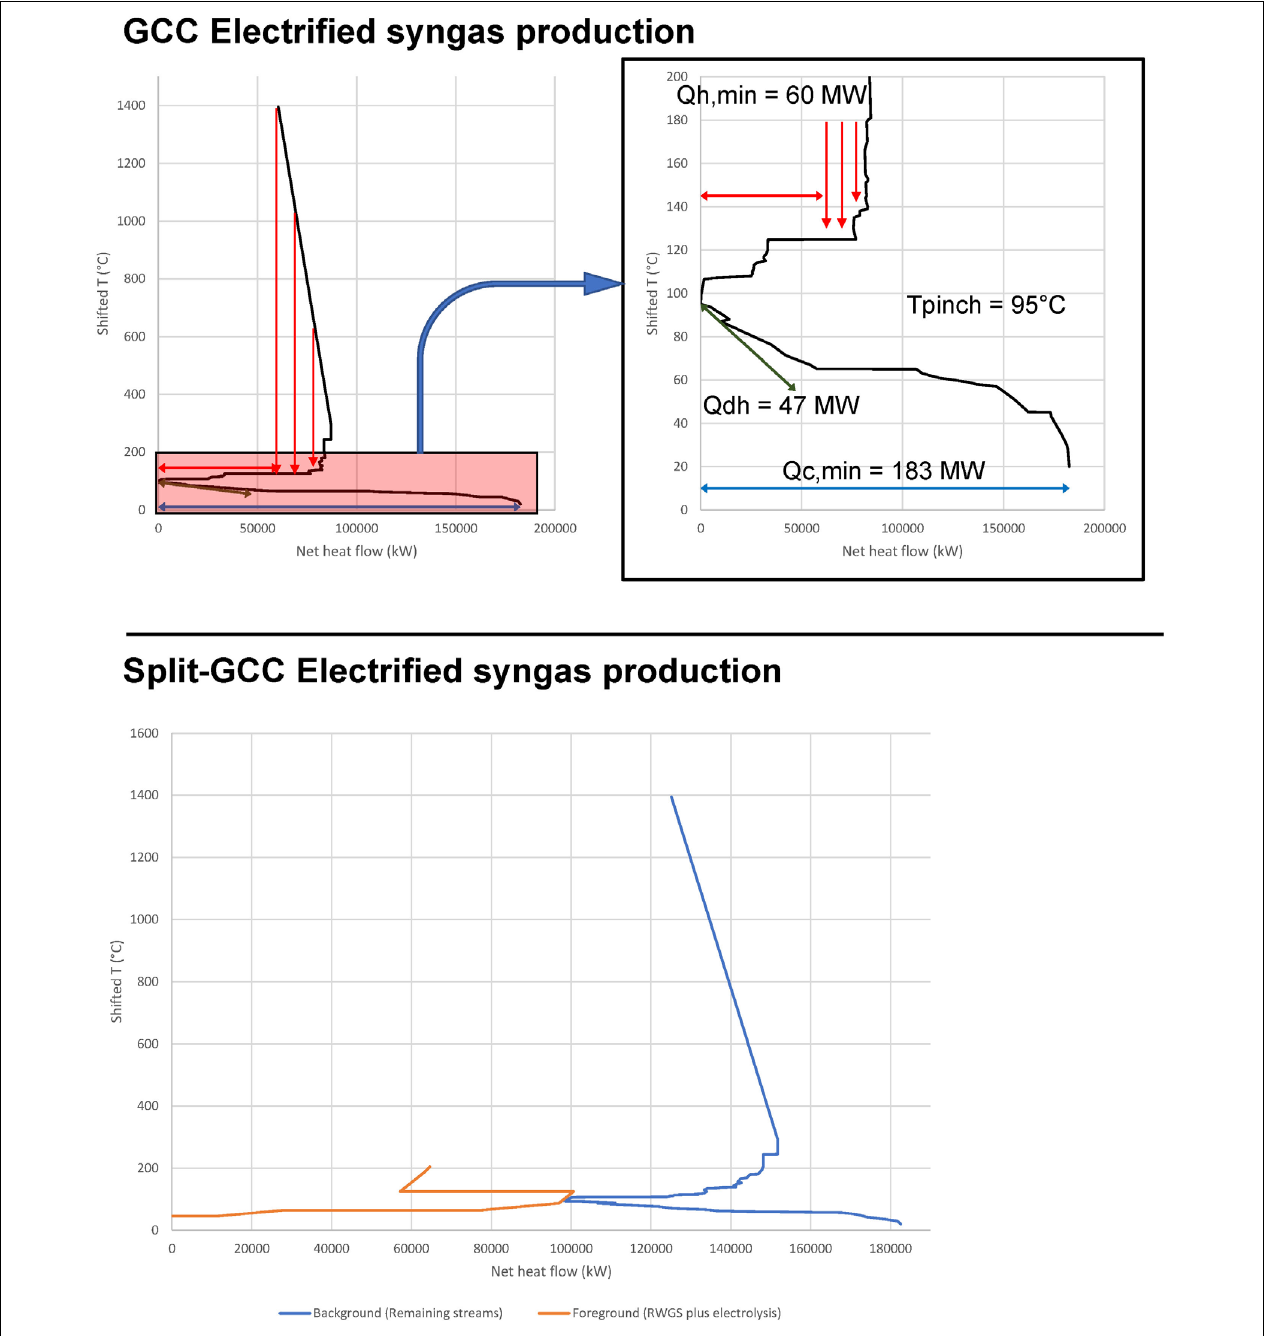
FIGURE 7 | GCC and split-GCC for the electrified syngas case. In the GCC, the minimum heating (Q h , min ) and cooling (Q c , min ) demands, as well as the district heating delivery potential (Q dh ) and the pinch temperature (T pinch ) are indicated. The red vertical arrows indicate the heat